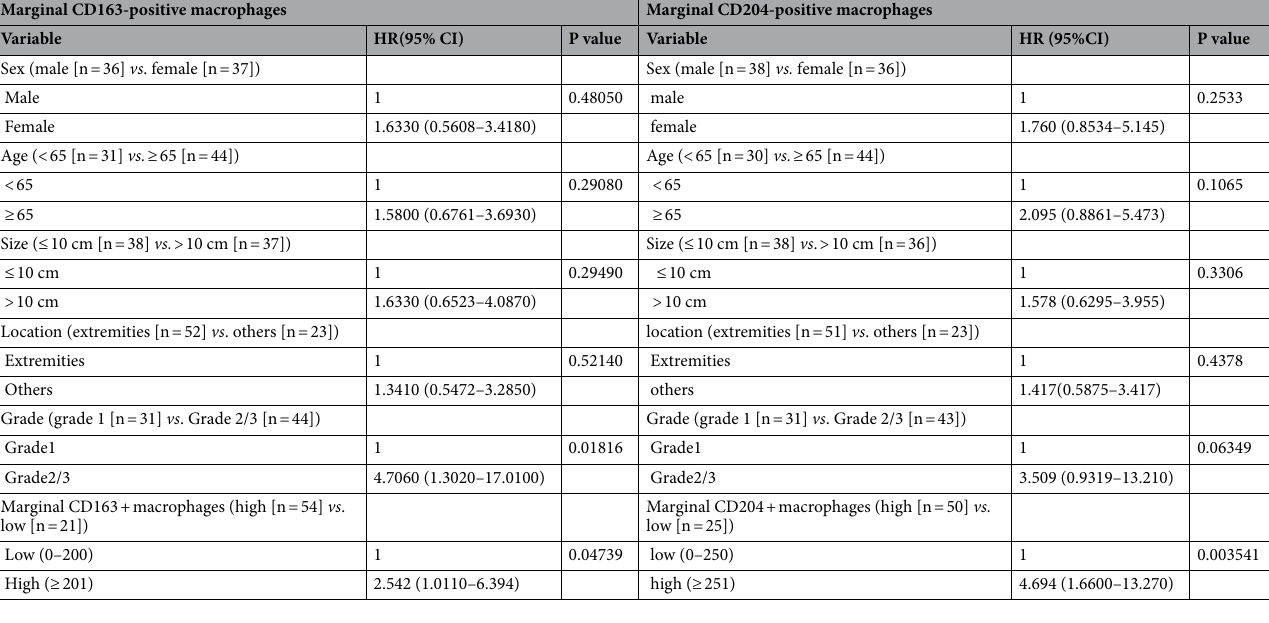
Table 4. Multivariate analysis. HRs (hazard ratios) were determined using a Cox proportional hazards model.